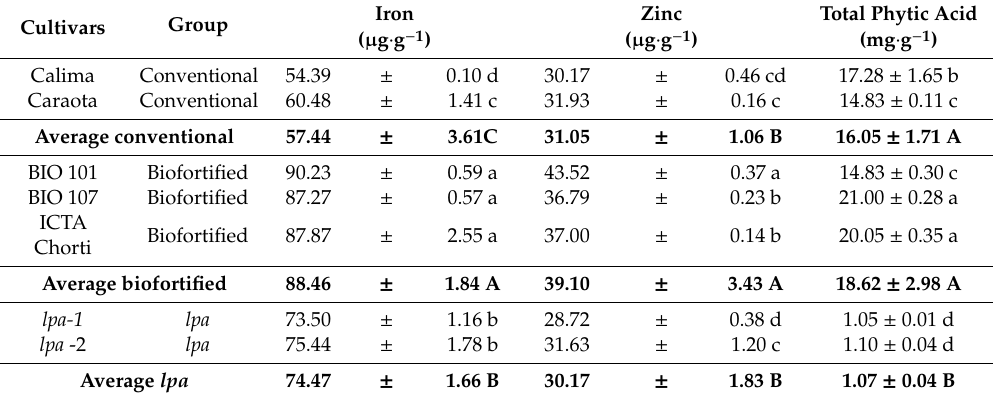
Table 2. Overview of iron, zinc and phytic acid content for the seven dry bean varieties that were selected for this study. The varieties were grouped as either conventional, biofortified or lpa